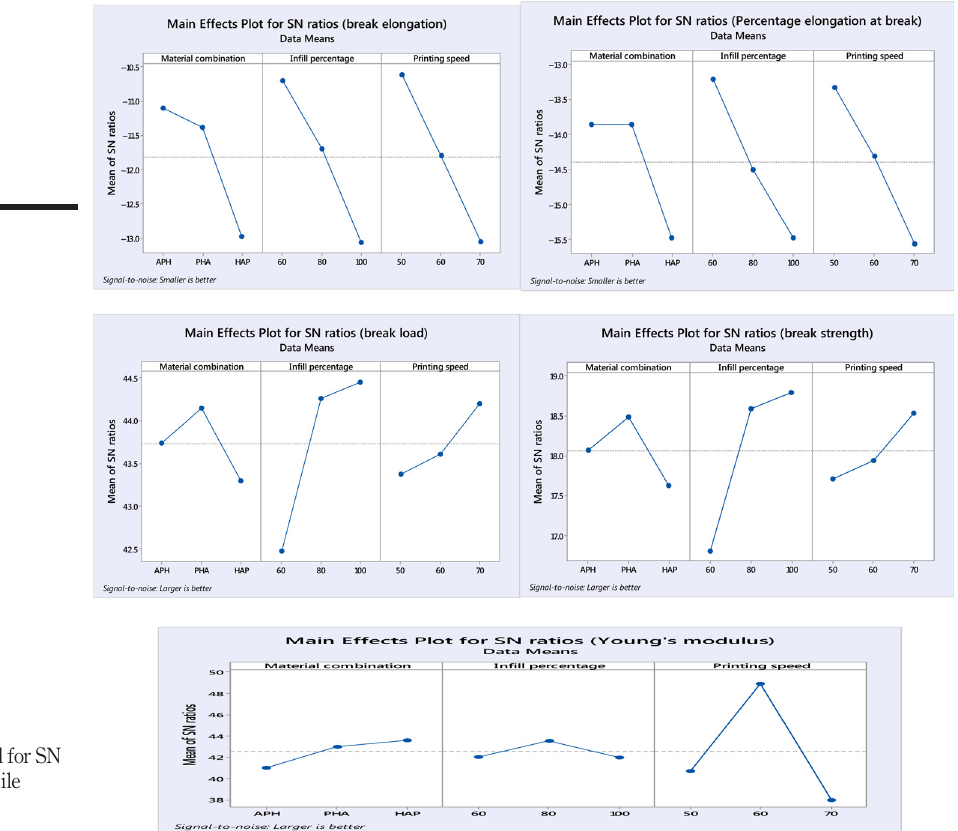
Figure 17. Linear model for SN ratios of